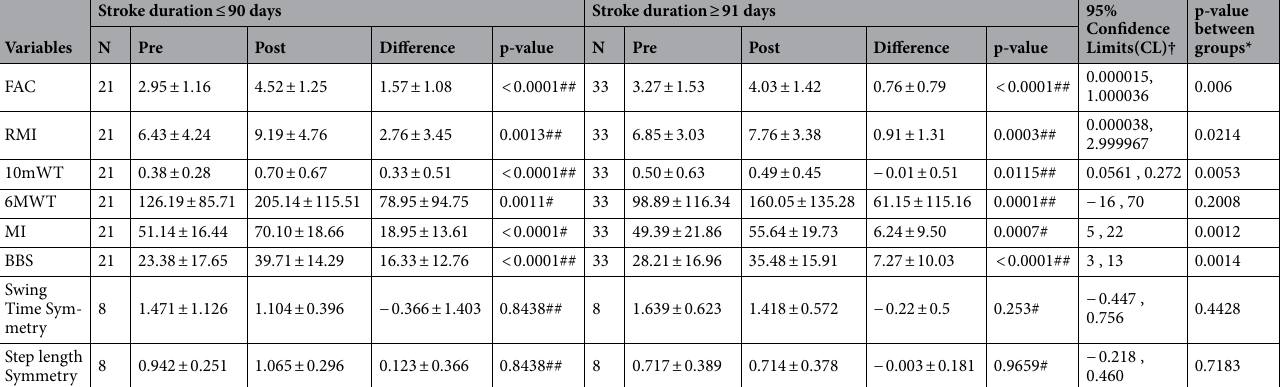
Table 4. The difference of outcome changes with stroke duration in the experimental group. FAC functional ambulation categories, RMI Rivermead Mobility Index, 10mWT 10-meter walk test, 6MWT 6-minute walk test, MI motricity index, BBS Berg balance scale. # p-value obtained from Paired t-test. ## p-value obtained from Wilcoxon signed rank test. † CL obtained from Wilcoxon’s rank sum test. *p-value obtained from Wilcoxon rank sum